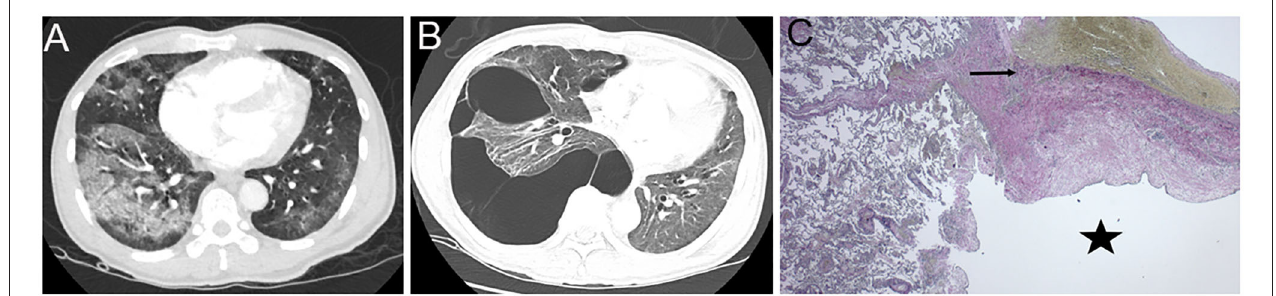
FIGURE 1 | Representative CT images of the chest. (A) During acute COVID-19 infection, CT chest with intravenous (IV) contrast revealed diffuse ground glass with consolidative changes and no evidence of bullous lung disease (BLD). (B) Three-month post-infection, a repeat CT chest with IV contrast showed right-sided bullous lesions with mediastinal shift. (C) The right lower lobe lung section stained with Elastic Van Gieson (EVG) was used to identify the pleural elastic membrane (arrow) to confirm the presence of the bullae (star) localized within the lung